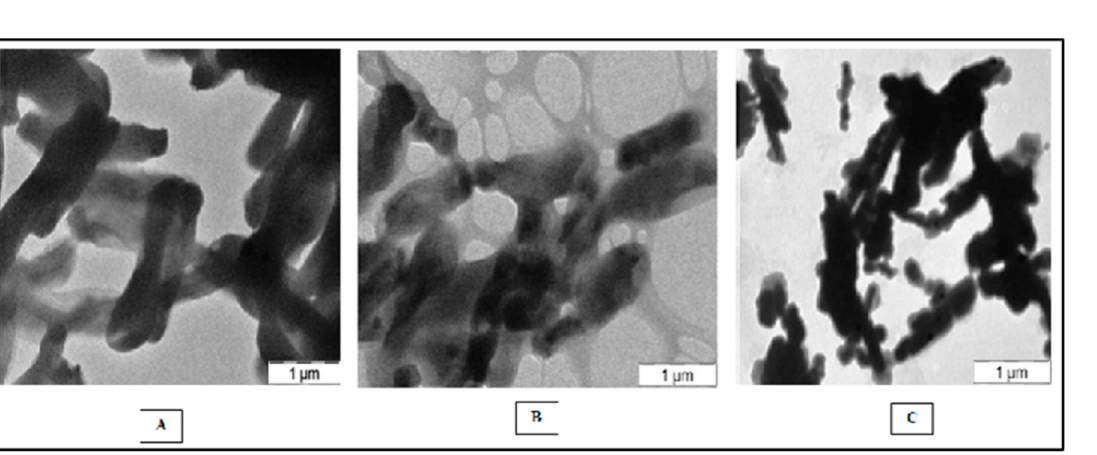
Figure 1. Shapes of the bacterial strains obtained using SEM analysis: ( A ) R. palustris NR MPPR, ( B ) R. palustris SMR 001, ( C ) R. feacalis N Raju MPPR.